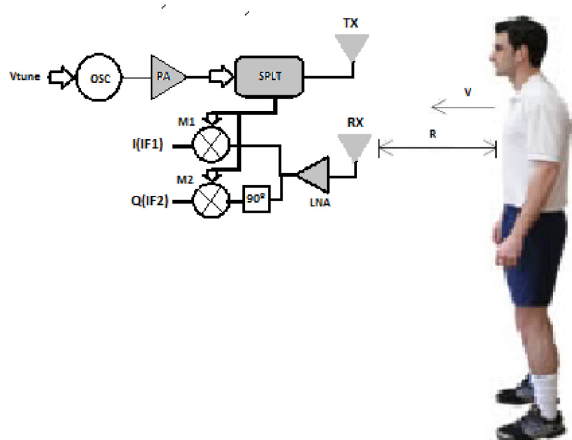
Figure 2. FM CW Doppler radar block diagram (Vtune = tuning voltage; OSC = voltage-controlled oscillator; M1, M2 = analogue mixers; I(IF1) = in phase intermediary frequency signal output; Q(IF2) = in quadrature intermediary frequency signal output; PA = preamplifier; SPLT = signal splitter; TX-transmit antenna; RX-receive antenna; LNA = low-noise amplifier.